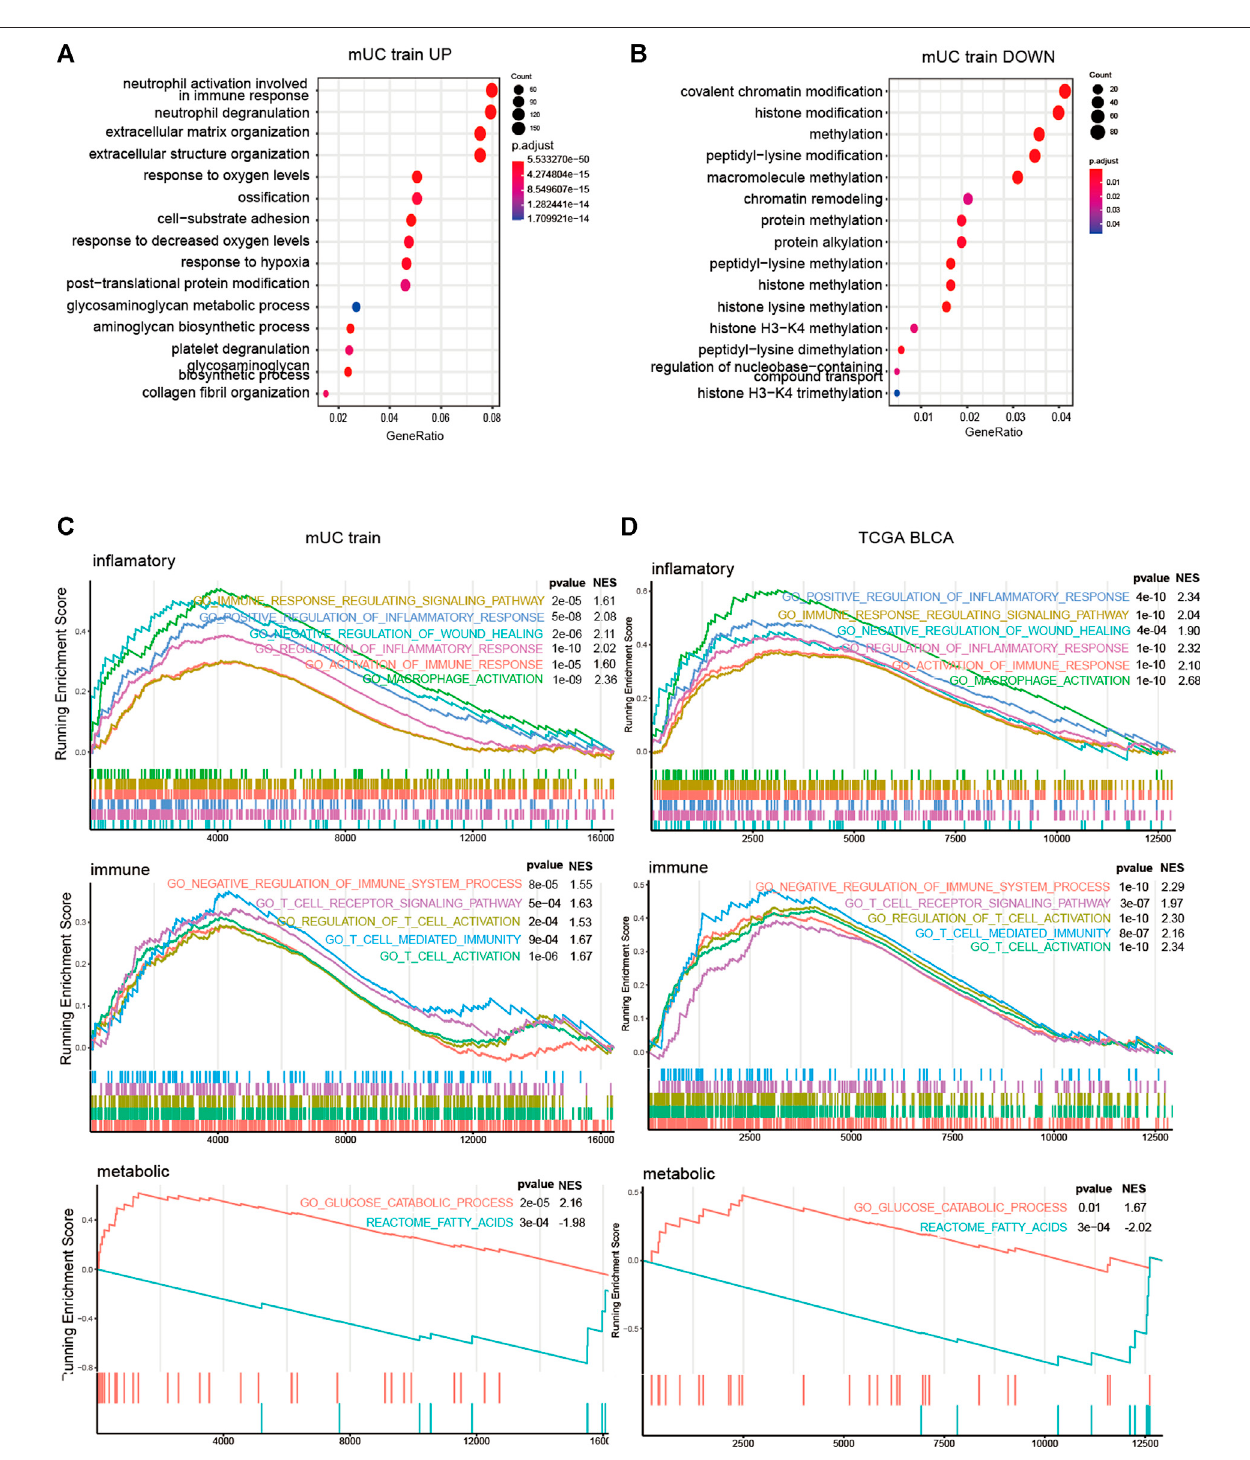
FIGURE 6 | The results of GSEA analysis of risk score group. (A,B) Histogram showed the enrichment of up-regulated genes ( p < 0.05, logFC > 0) and down regulated genes ( p < 0.05, logfc < 0) in the top15 pathways of the GO gene set ( p < 0.05, logFC < 0). The pathways were mainly the intercellular and hypoxia related pathways. (C,D) Results of GSEA analysis on in fl ammatory pathway, immune pathway, glucose metabolism and lipid metabolism in metastatic urothelial carcinoma (FigC) and TCGA BLCA (FigD) cohort ( p < 0.05).